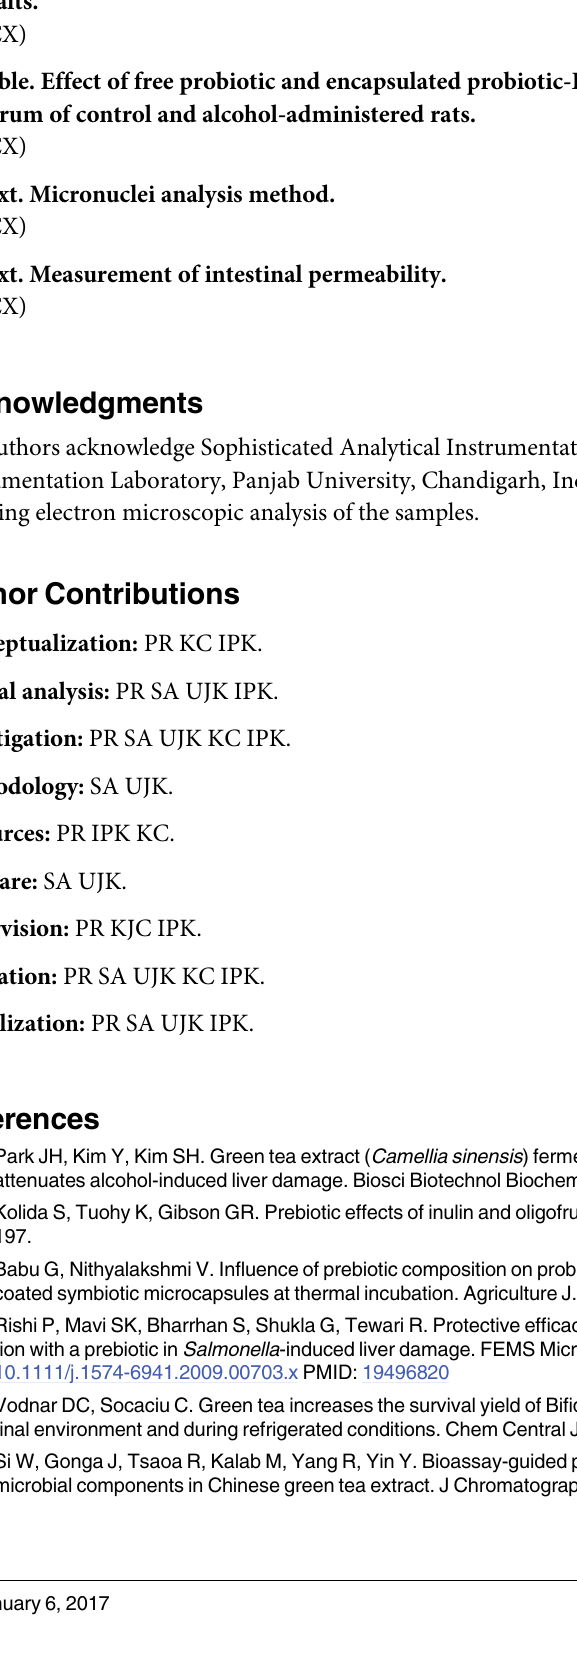
S1 Table. Log CFU of L . plantarum entrapped in probiotic- EGCG beads in SGF, SIF and 10 Bile salts. S2 Table. Effect of free probiotic and encapsulated probiotic-EGCG on hepatic markers in the serum of control and alcohol-administered